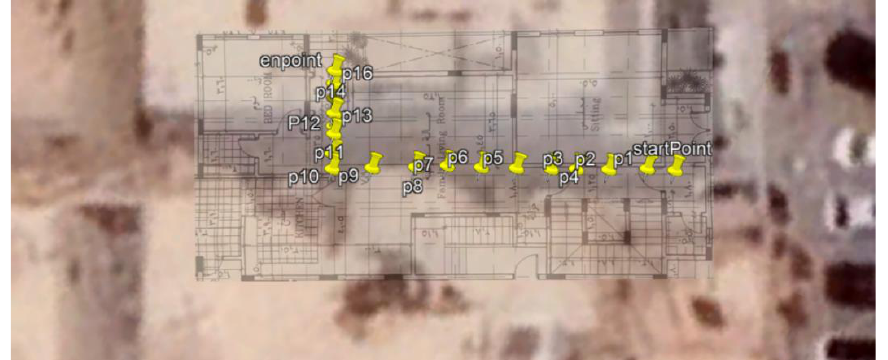
Figure 25. Georeferenced blueprint of the building.